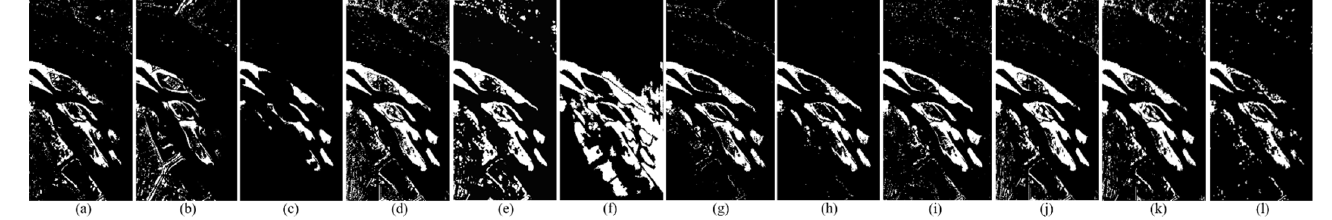
Figure 6. Binary detection results in the Yancheng dataset: ( a ) ground truth, ( b ) LSCD, ( c ) ASCD, ( d ) HOSVD, I TDRD, ( f ) PCANet, ( g ) DSFANet, ( h ) HI-DRL, ( i ) SSTN, ( j ) UTT-SVD, ( k ) UTT-noSVD, and ( l ) STT.